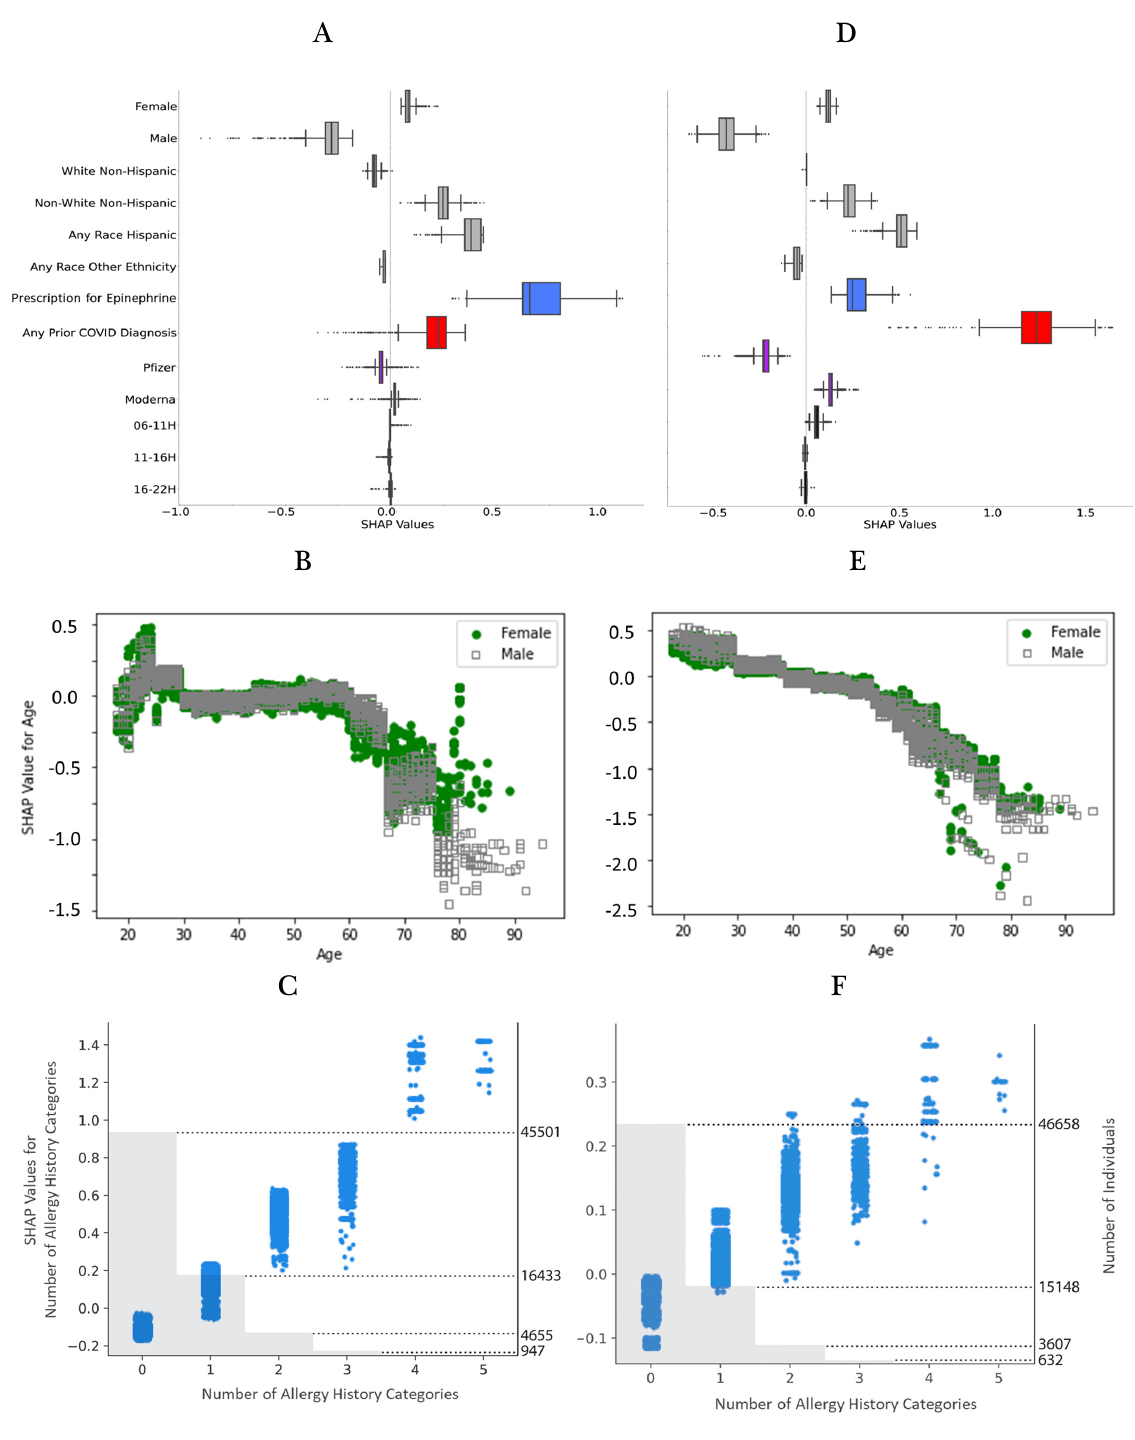
Figure 3. ( A ): SHAP value boxplot that shows the direction of impact of each variable on model’s output for allergic side effects. Positive SHAP values are indicative of having side effects, while negative SHAP values are indicative of not having side effects. Box limits indicate 25th and 75th percentile, vertical line within the box indicates 50th percentile, and other vertical lines indicate 5th and 95th percentiles; ( B ): SHAP feature independent plot for age vs. sex showing the impact of age on model output and ( C ): SHAP value scatter plot for number of allergy history categories showing the impact of this variable on model output. ( D – F ): as in ( A – C ) except for non-allergic side effects. Colors in ( A , D ): grey—demographics, blue—prescription for epinephrine, red—any prior COVID diagnosis or positive test, purple—vaccine manufacturer, black—time-of-day of